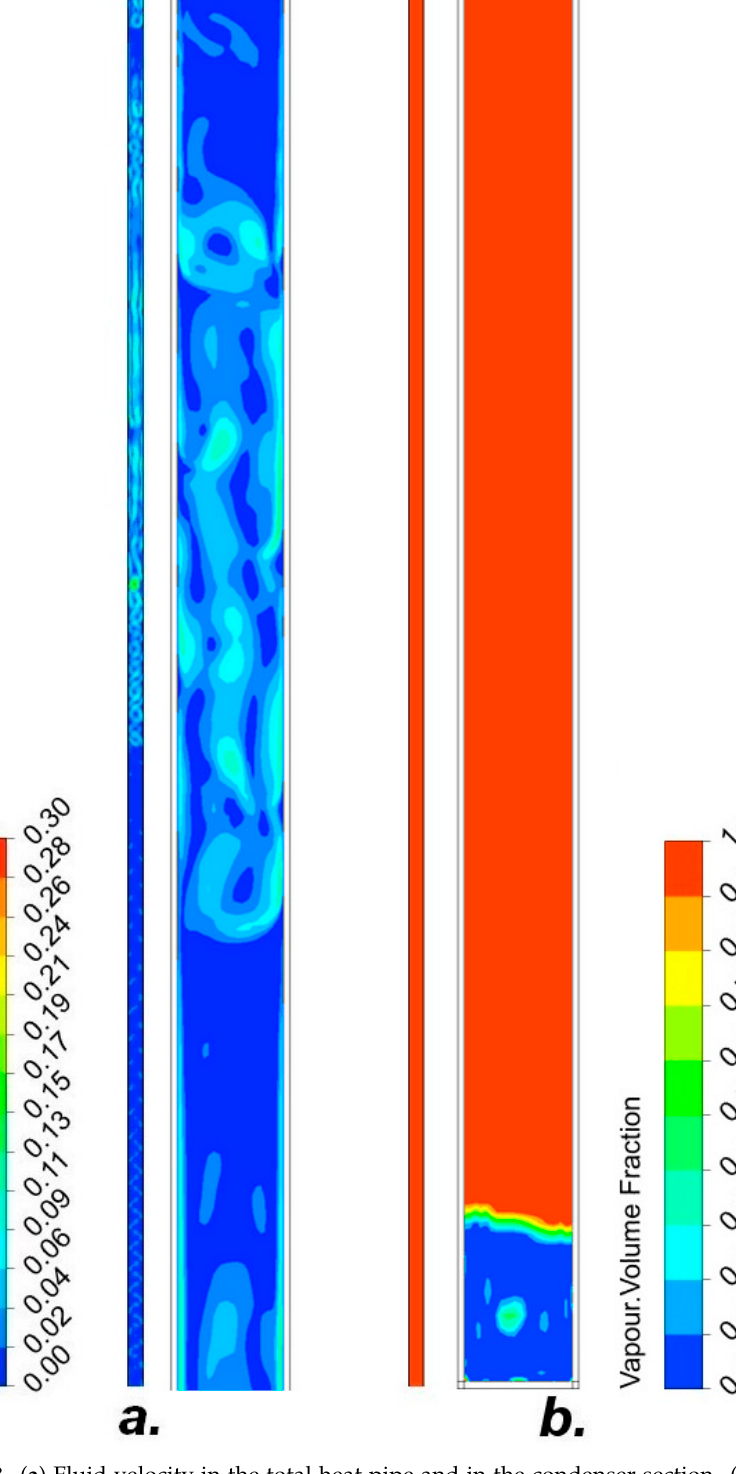
Figure 13. ( a ) Fluid velocity in the total heat pipe and in the condenser section. ( b ) The volume fraction of steam in the total heat pipe and in the evaporator section.